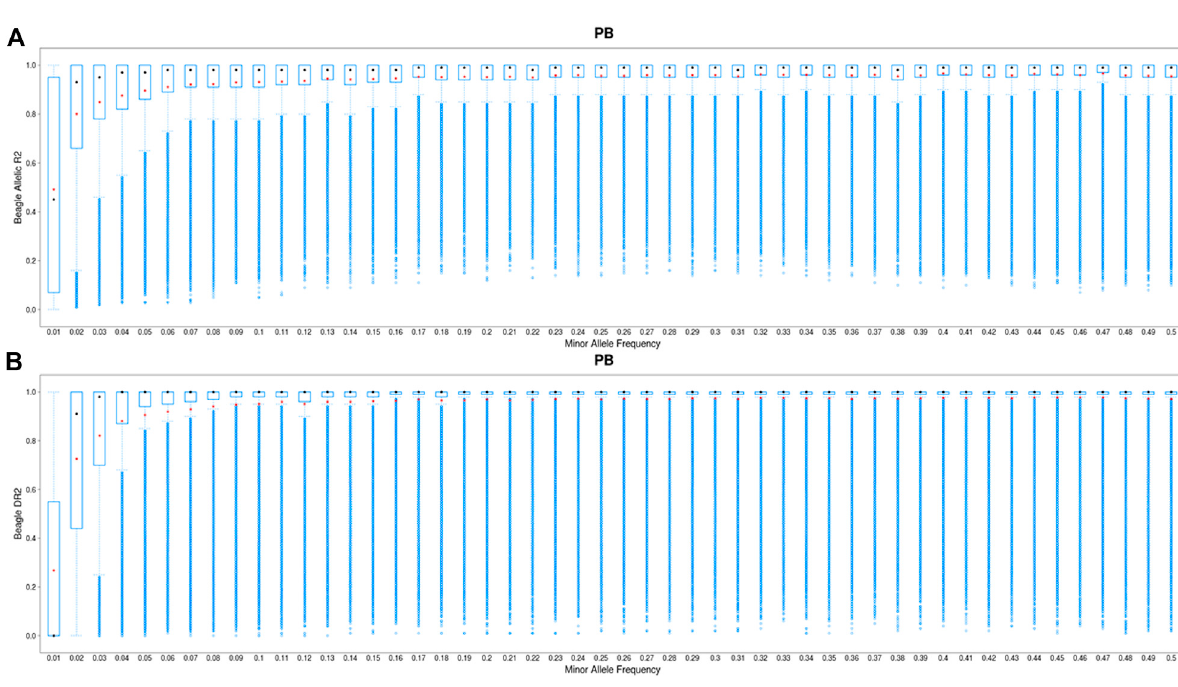
FIGURE 3 Boxplot showing the imputation accuracy (allelic DR 2 ) to whole-genome sequence (WGS) versus minor allele frequency (MAF) for PBs using a one-step imputation procedure from 50K to WGS (A) and a two-step imputation procedure, from 50K to 660K to WGS (B) . The x -axis represents differentclasses ofMAF(ranging from0.01 to0.5,withthestepsof0.01), and y -axis showstheimputation accuracies.Theredand blackdotsarethe mean and median of imputation accuracies across individuals in each MAF class. Average DR 2 across the genome is 0.966 and 0.985 for the one-step and two-step imputation procedure,